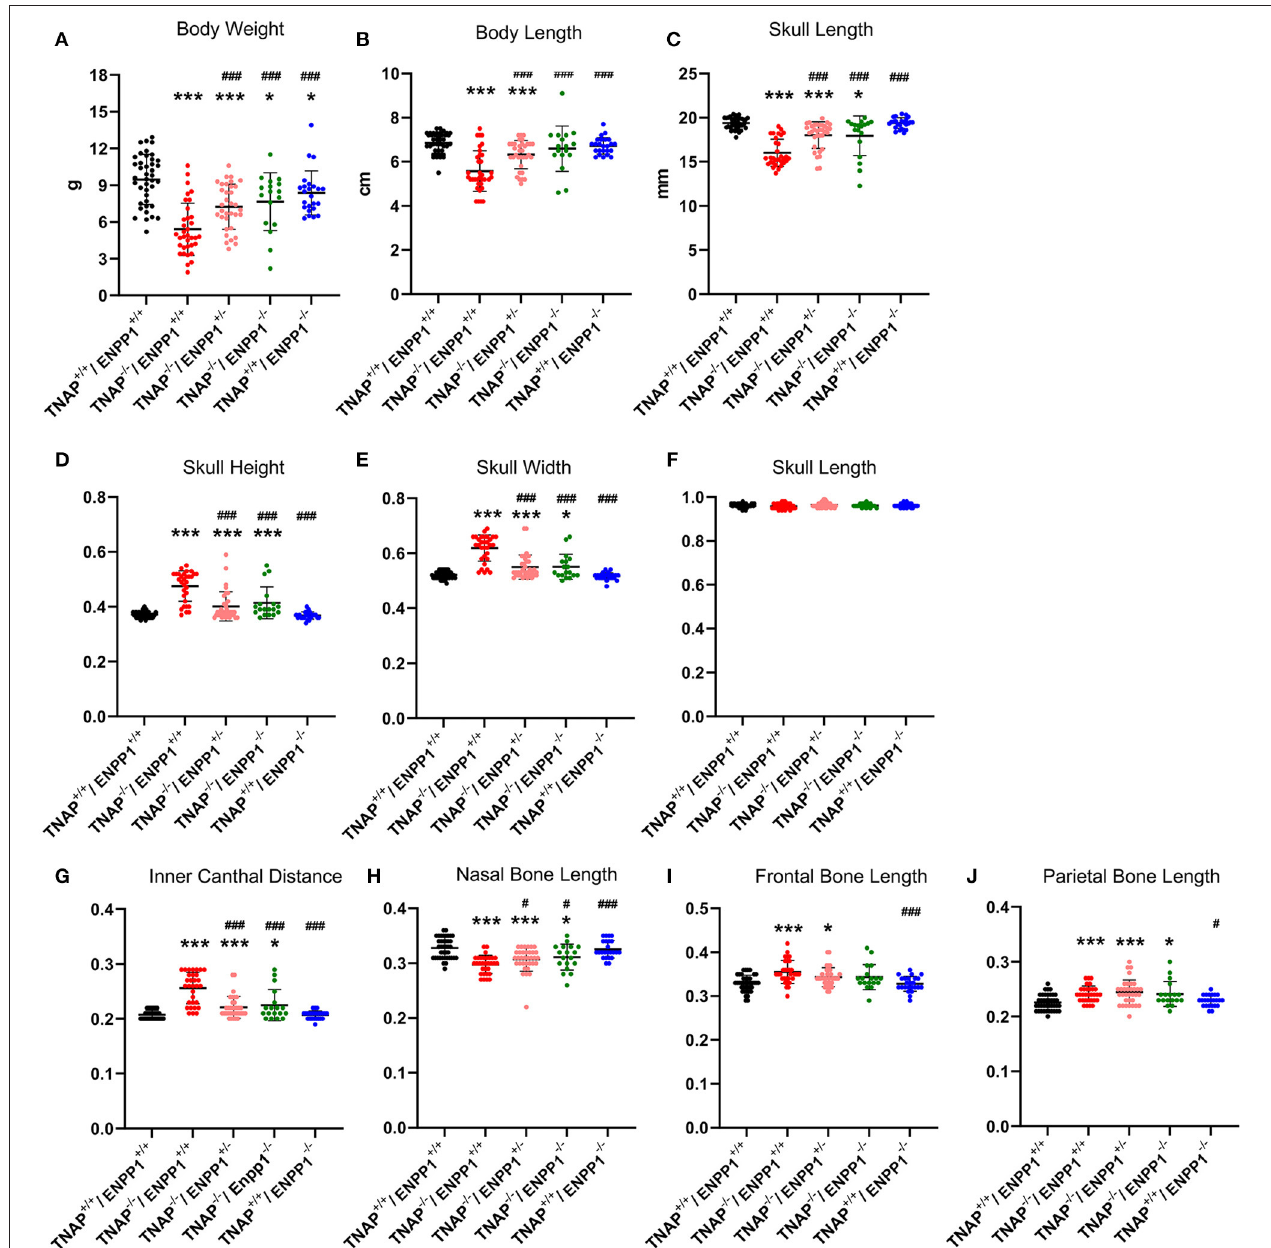
FIGURE 2 | TNAP and ENPP1 ablation effects on body and craniofacial measurements. Total body weight (A) , body length (B) , and skull length (C) for single mutant, double mutant and wild type postnatal day 17 mice are shown. Skull measurements normalized to skull length to account for differences in skull/mouse size for single mutant, double mutant and wild type postnatal day 17 mice are shown (D–J) . TNAP − / − /ENPP1 + / + mice are significantly diminished in body weight, body length and skull size, and exhibit skull shape abnormalities when compared to TNAP + / + /ENPP1 + / + mice. TNAP − / − /ENPP1 − / − mice show significantly greater body weight, body length, skull length with improvements in skull shape, when compared to TNAP − / − /ENPP1 + / + mice. * p < 0.05 vs. TNAP + / + /ENPP1 + / + mice, *** p < 0.005 vs. TNAP + / + /ENPP1 + / + mice, # p < 0.05 vs. TNAP − / − /ENPP1 + / + mice, ### p < 0.005 vs. TNAP − / − /ENPP1 + / + mice.